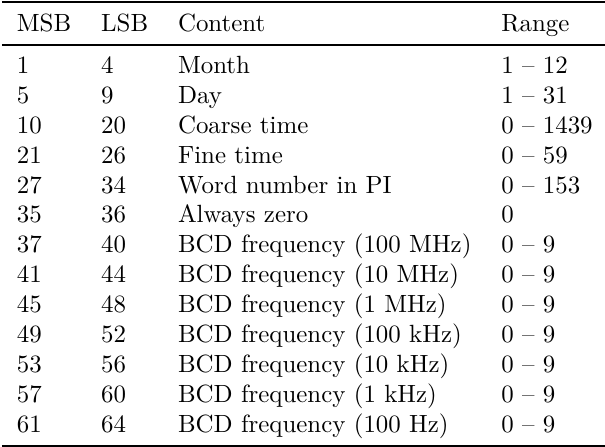
Table 3: Construction of the SoDark tweak from information known to both sender and receiver. The same bit numbering as in [DoD17] is used, starting with 1 at the most significant bit (MSB) of the first byte and ending with 64 at the least significant bit (LSB) of the last byte. (BCD=Binary Coded Decimal, PI=Protection